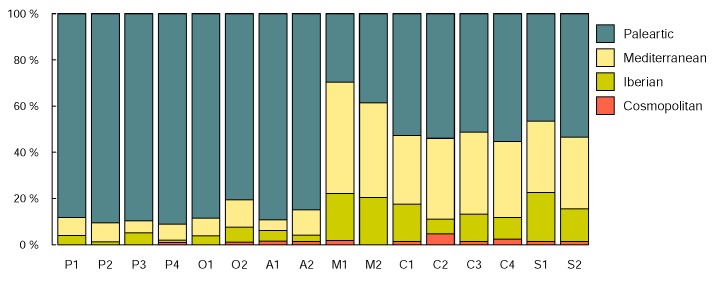
Plot with percentages of species of different biogeographic categories, namely Palearctic, Mediterranean, Iberian, Cosmopolitan, per National Park.